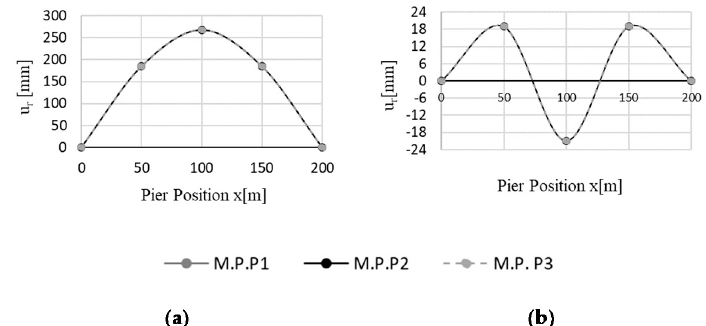
Figure 12. Regular bridge—deck displacements derived by performing pushover analysis (ag = 0.7 g), with a load pattern proportional to the main mode shapes, with respect to different monitoring points (M.P.). Pushover with Mode 2 ( a ) or Mode 4 ( b ).